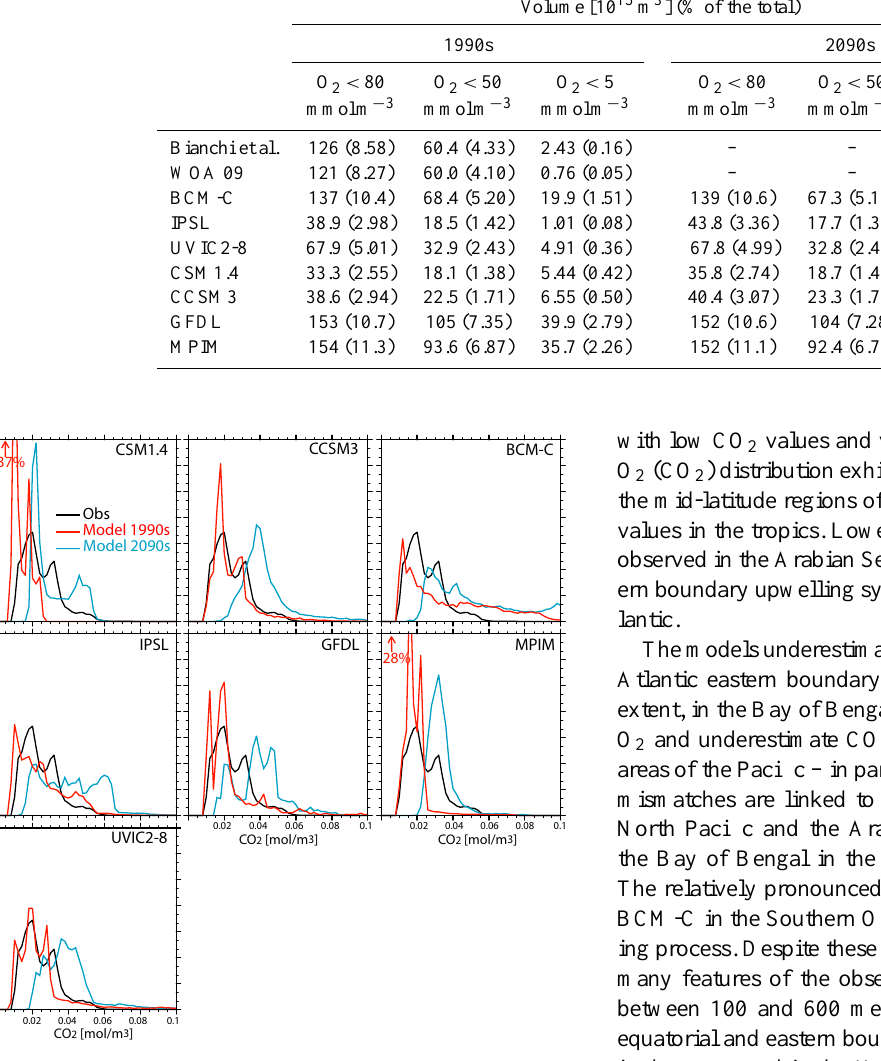
Fig. 3. CO 2 frequency distribution in the UML (from 100 to 600m depth), obtained by sampling the volume fraction that falls within 0.02molm − 3 intervals. Black line: observation-based distribution (from GLODAP and WOA 09 gridded data). Red: 1990s mod- eled distribution (decadal mean). Blue: 2090s modeled distribution (decadal